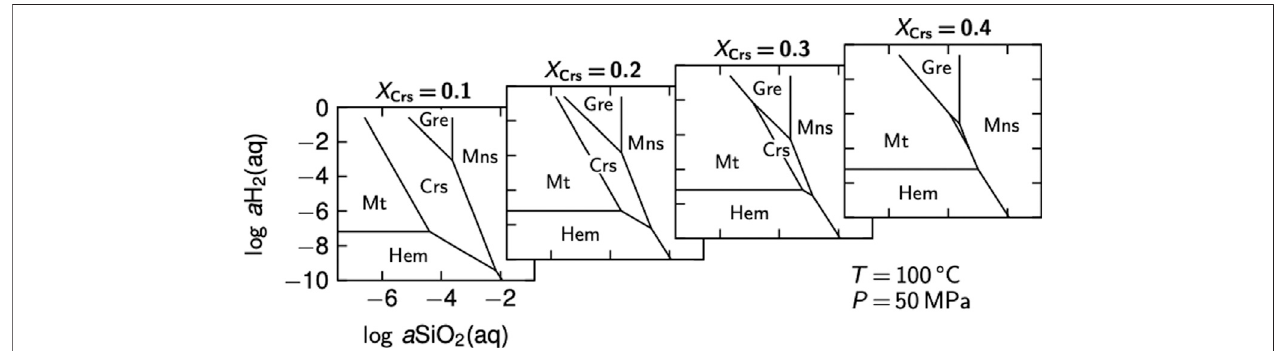
FIGURE 8 | Stability of Mg-serpentine – cronstedtite mixtures with increasing fraction of cronstedtite, X Crs (from left to right). Pure cronstedtite is not stable at the 500 MPaand100 ° C,but serpentine withlowcronstedtite components may bestable atsilicaactivities thatareintermediate betweenthoseofmagnetiteand greenalite. It may hence form under quite variable conditions, which are conceivable for diverse settings and lithologies including harzburgite and dunite at MORs. Serpentine with cronstedtitefractionsaslowas0.1require a SiO